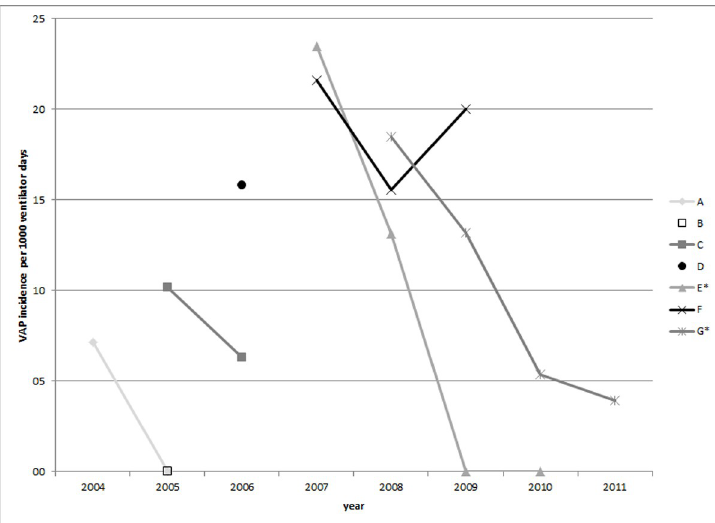
Fig 2. Average yearly incidence density, per 1000 ventilation days, of ventilator-associated pneumonia, per hospital. Hospitals with significant reduction are indicated with an asterisk ( � ).